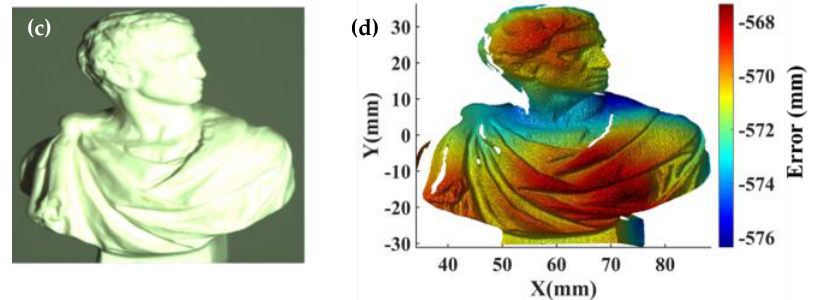
Figure 6. 3D geometries with the proposed system calibration method. ( a , c ) Photographs; ( b , d ) reconstructed geometries.